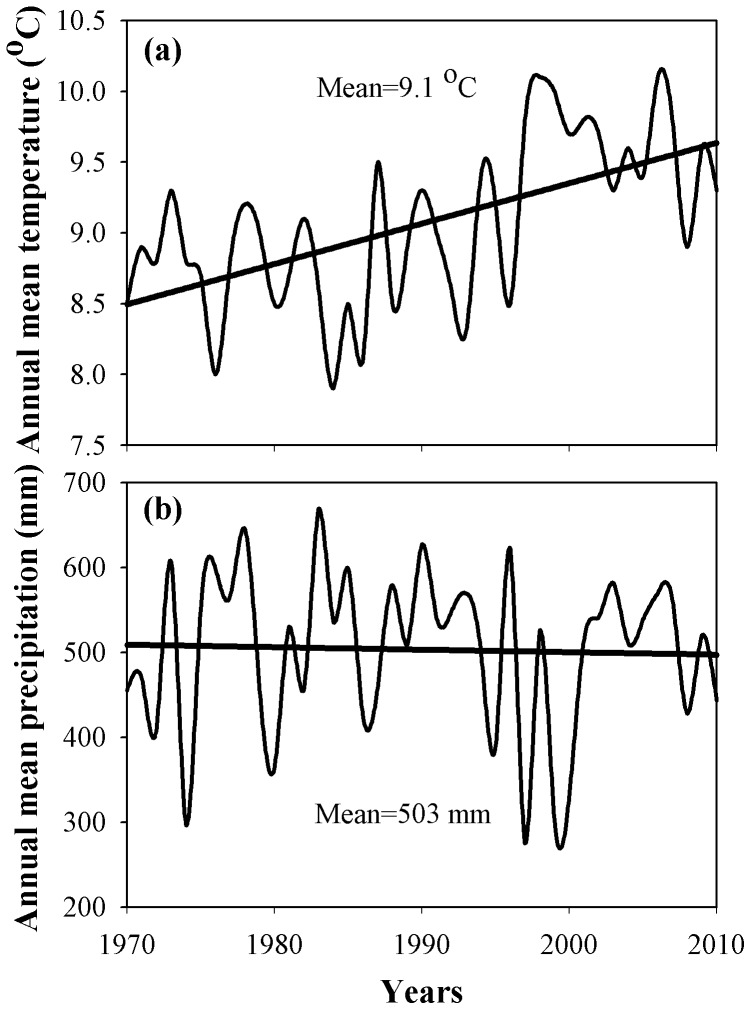
Annual mean temperature (a) and Annual mean precipitation (b) at the study site 1970–2010.Note: the solid lines in the figures a, b are the dynamic fitting curve for annual mean temperature, annual mean precipitation changes with time.